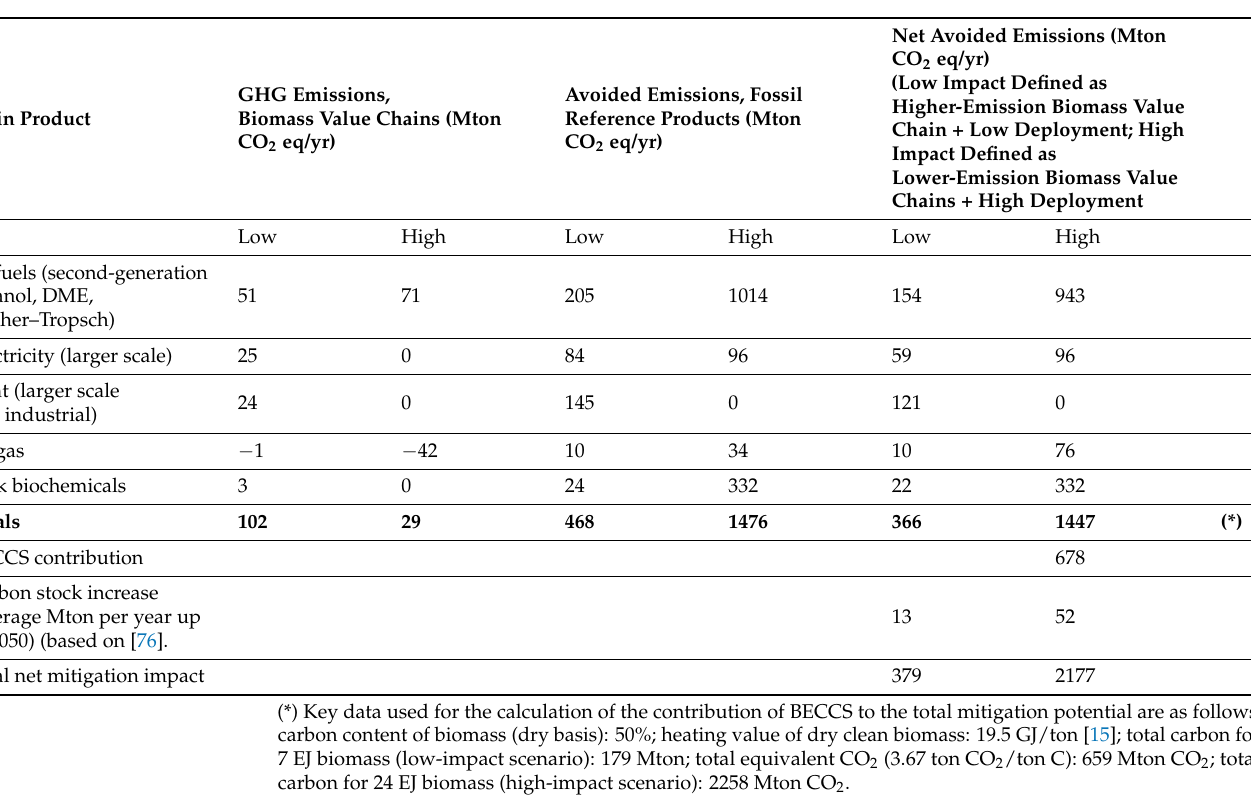
Table 4. Annual emissions (Mton CO 2 eq), avoided emissions and net emissions per year per main biomass application for the low-impact and high-impact scenarios in the year